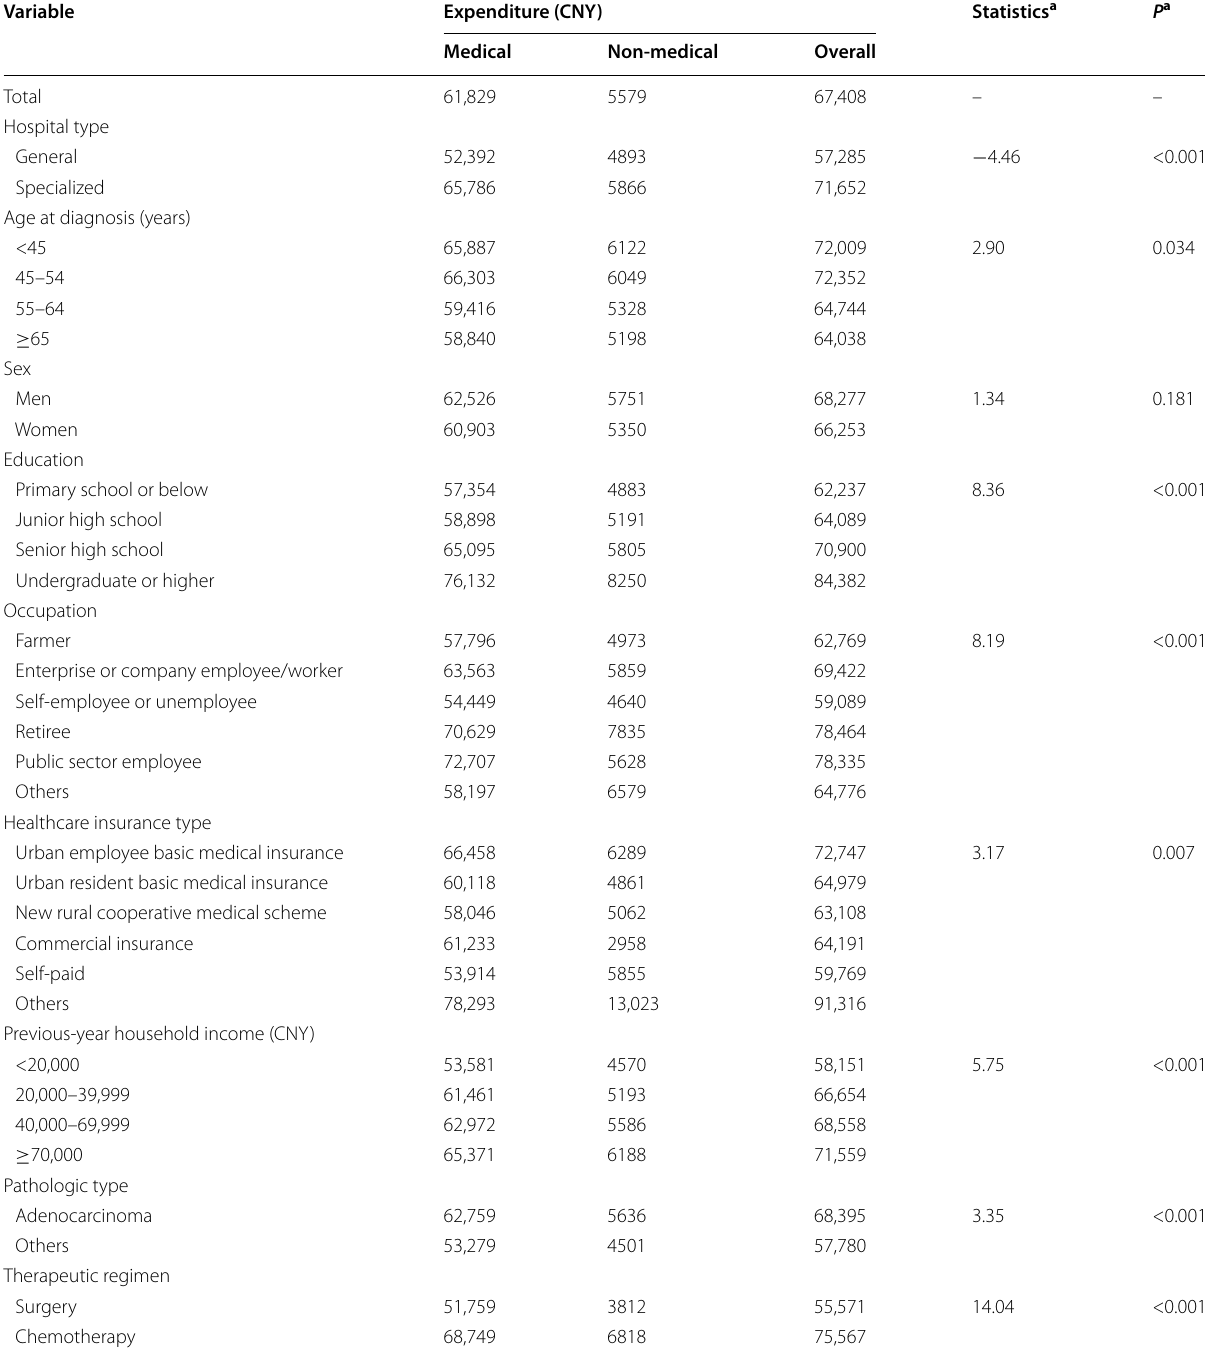
Table 3 Univariate analysis of overall expenditure for diagnosis and treatment of 2356 patients with colorectal